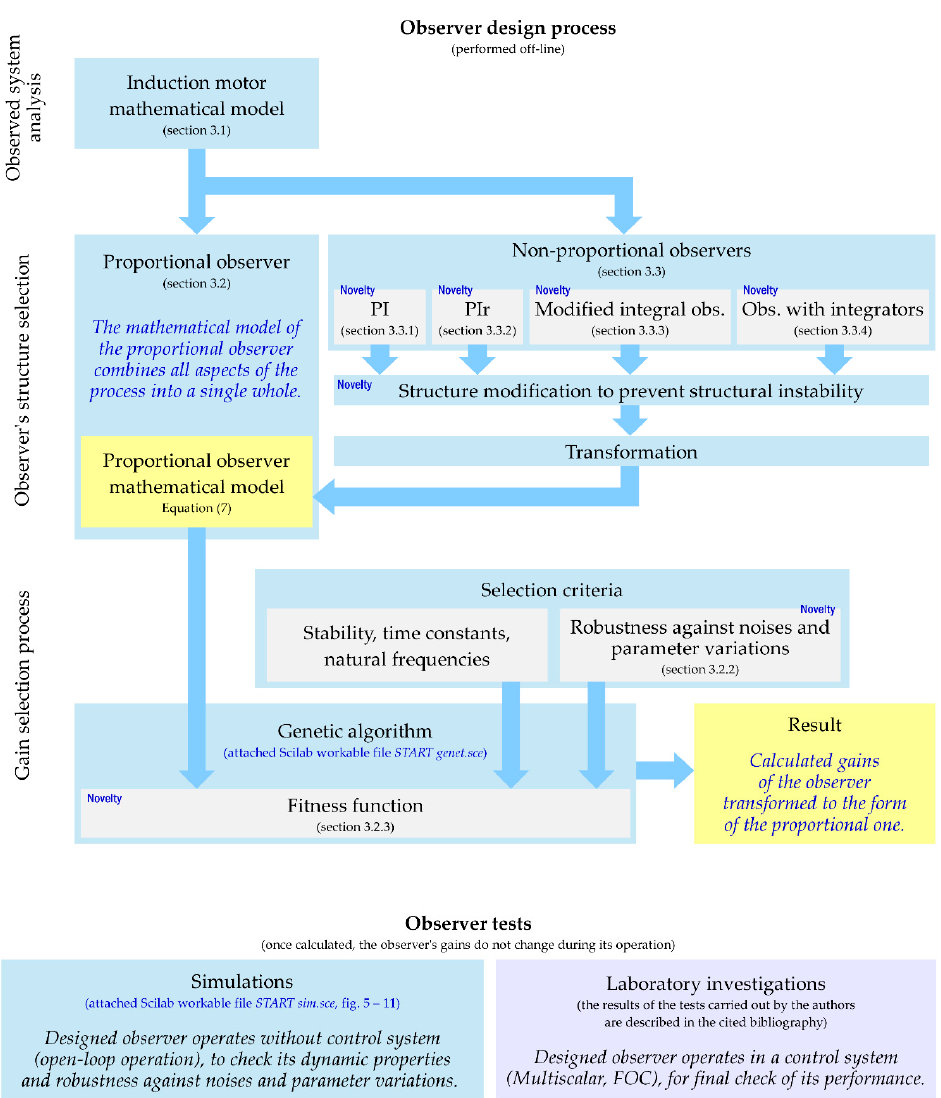
Figure 1. Methodology workflow.